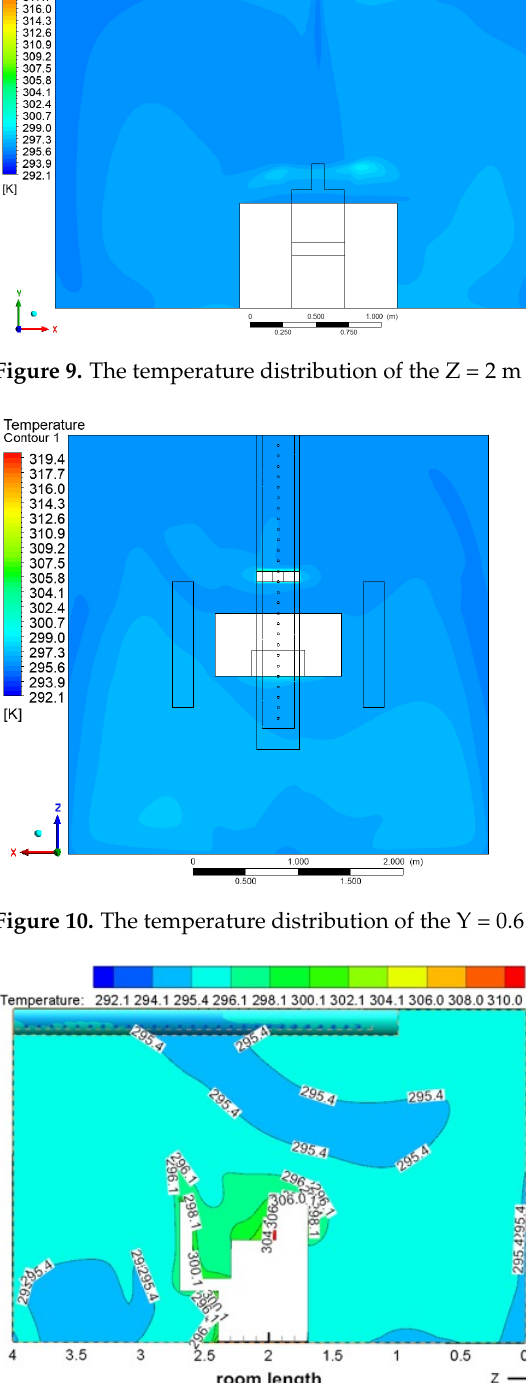
Figure 11. The temperature distribution of the X = 2 m section.